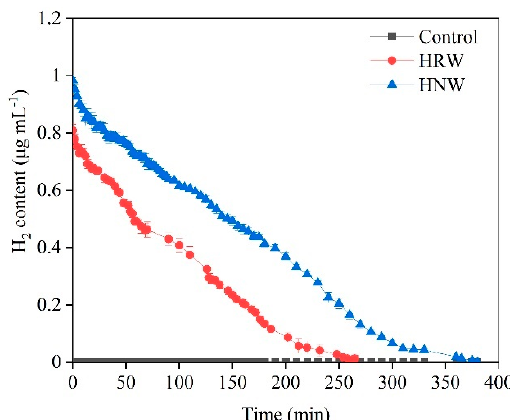
Figure 1. Changes in H 2 content of fresh hydrogen nanobubble water (HNW) and hydrogen-rich water (HRW).